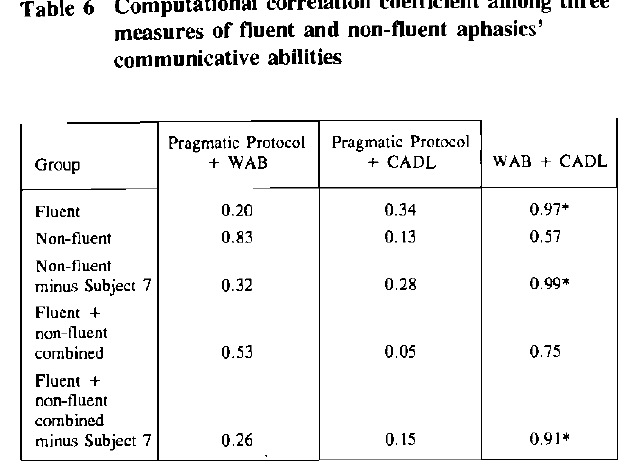
Table 6 Computational correlation coefficient among three measures of fluent and non-fluent aphasics' communicative